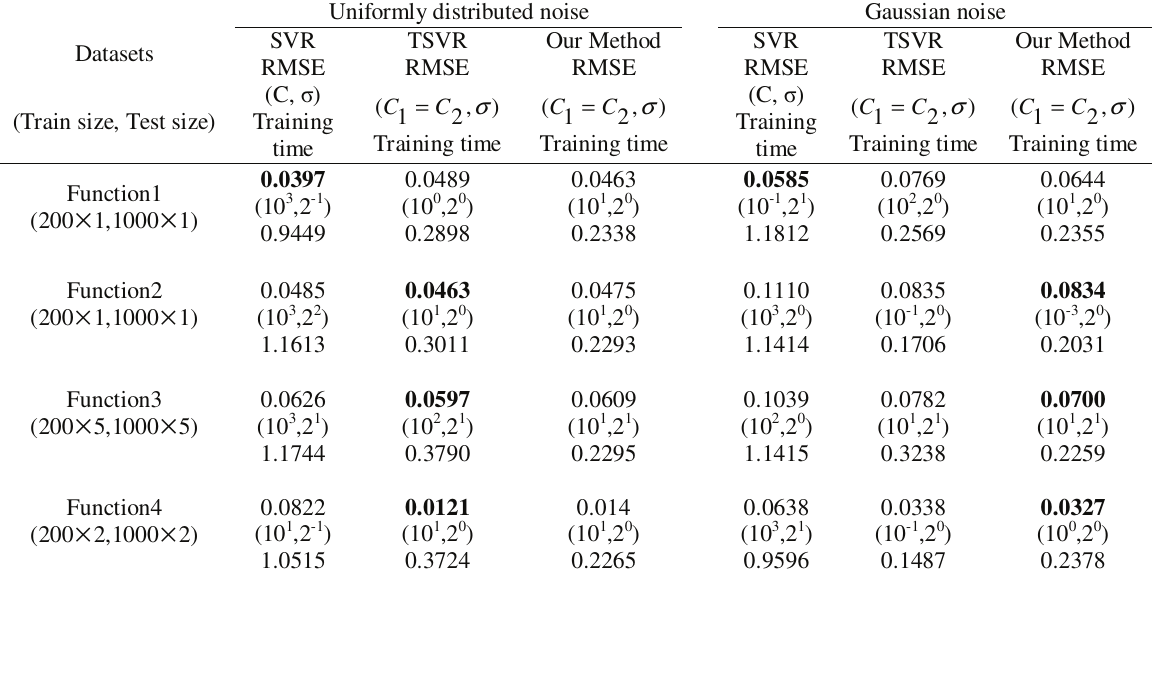
Table 2. Performance comparison of the proposed method with SVR and TSVR on synthetic datasets for uniformly distributed and Gaussian noises. RMSE and training time (seconds) were used for comparison. Gaussian kernel was employed. The best result is shown in